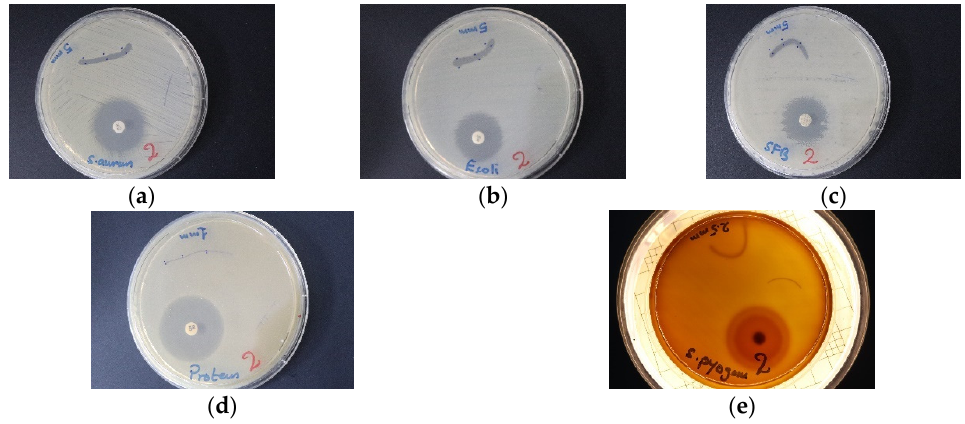
Figure 13. Antimicrobial agar plate methods of TCA-AgNP-PI dip-coated PGA with positive controls (antibiotics). From left to right: against ( a ) S. aureus ATCC 25923 ; ( b ) E. coli WDCM 00013 ; ( c ) clinical sample Bacillus subtilis ; ( d ) P. mirabilis ATCC 29906 ; ( e ) S. pyogenes ATCC 19615 .